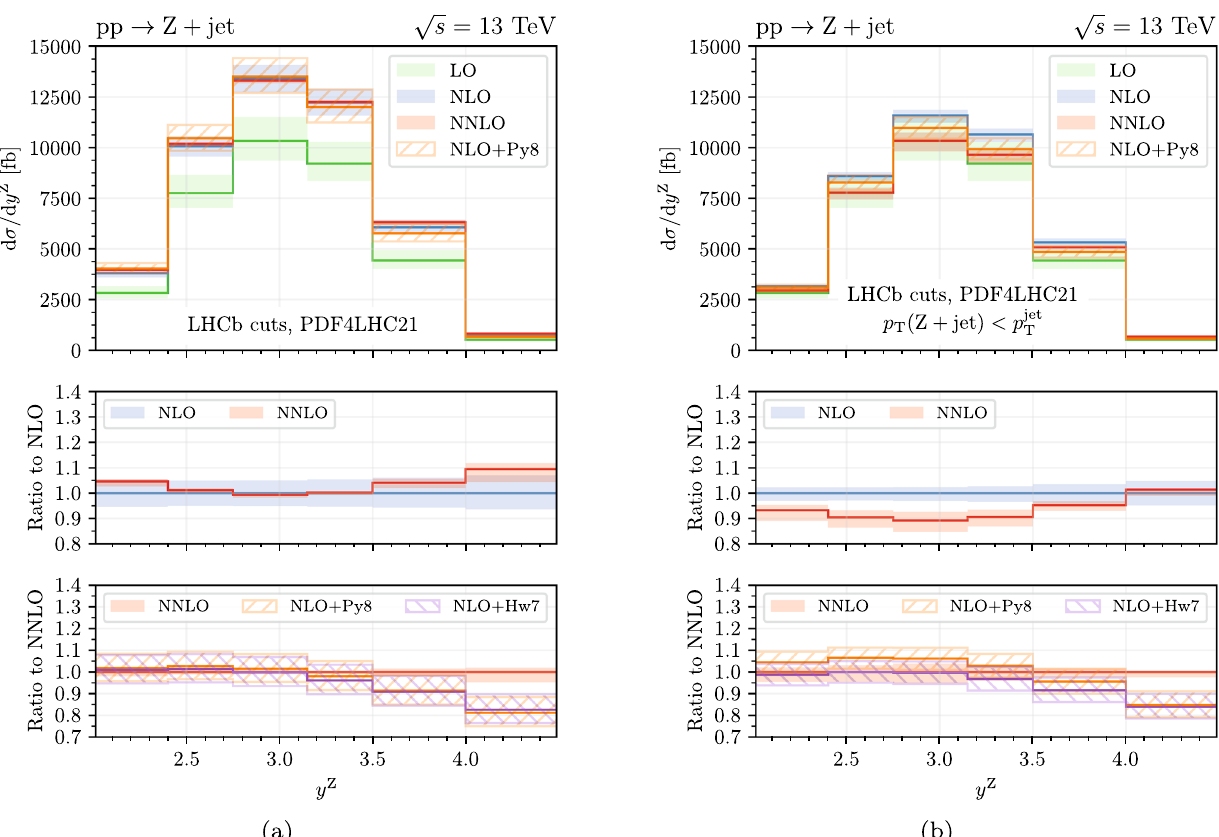
Fig. 4 Comparisonofparton-levelpredictionsfortherapiditydistribu- tionoftheleptonpair y Z fortheunflavouredprocessZ + jet:fixed-order predictions at LO (green), NLO (blue) and NNLO (red); NLO+PS pre-